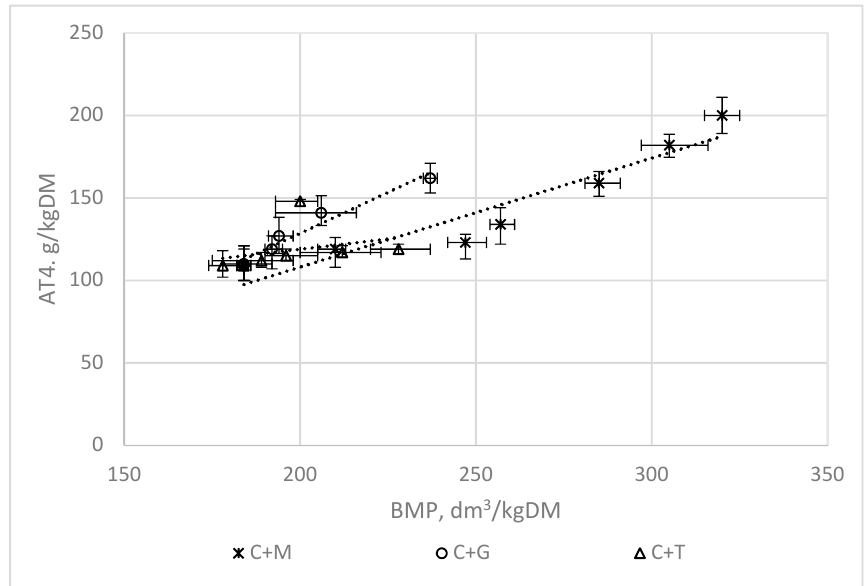
Figure 7. The correlations between AT4 and the BMP. Int. J. Environ. Res. Public Health 2019 , 16 , x